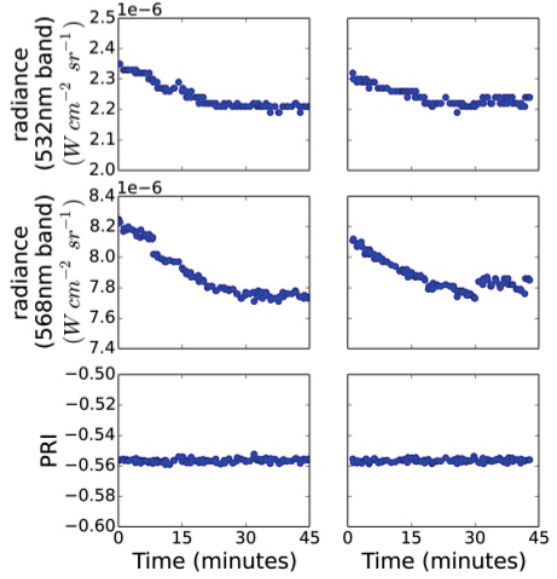
Figure 5. Change in reflected radiance measured in the two PRI wavebands over time as turf was exposed to approximately 350 μ mol·m − 2 ·s − 1 . First series of measurements are shown in the first column. The second series of measurements were acquired after acclimating the turf to darkness for two hours and are shown in the second